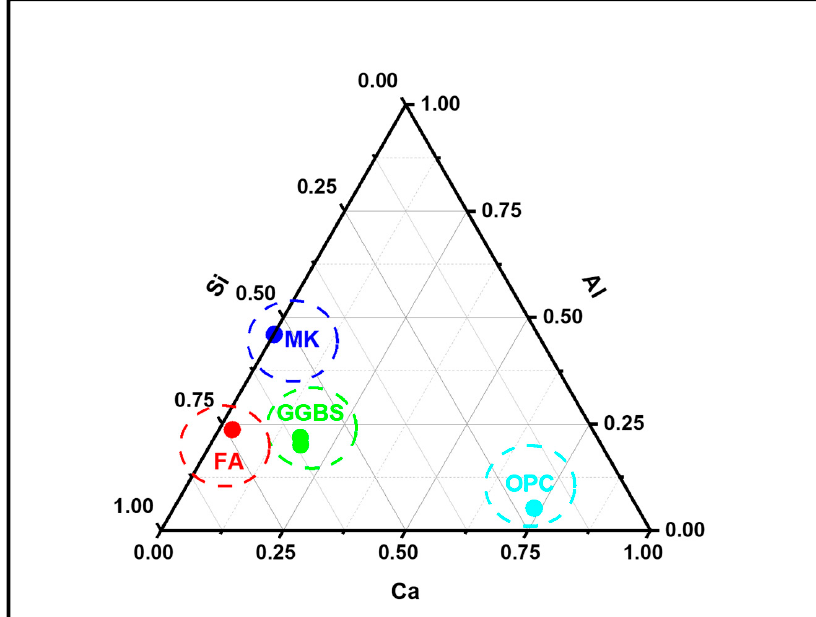
Figure 13. Ternary plot of Ca vs. Al vs. Si.